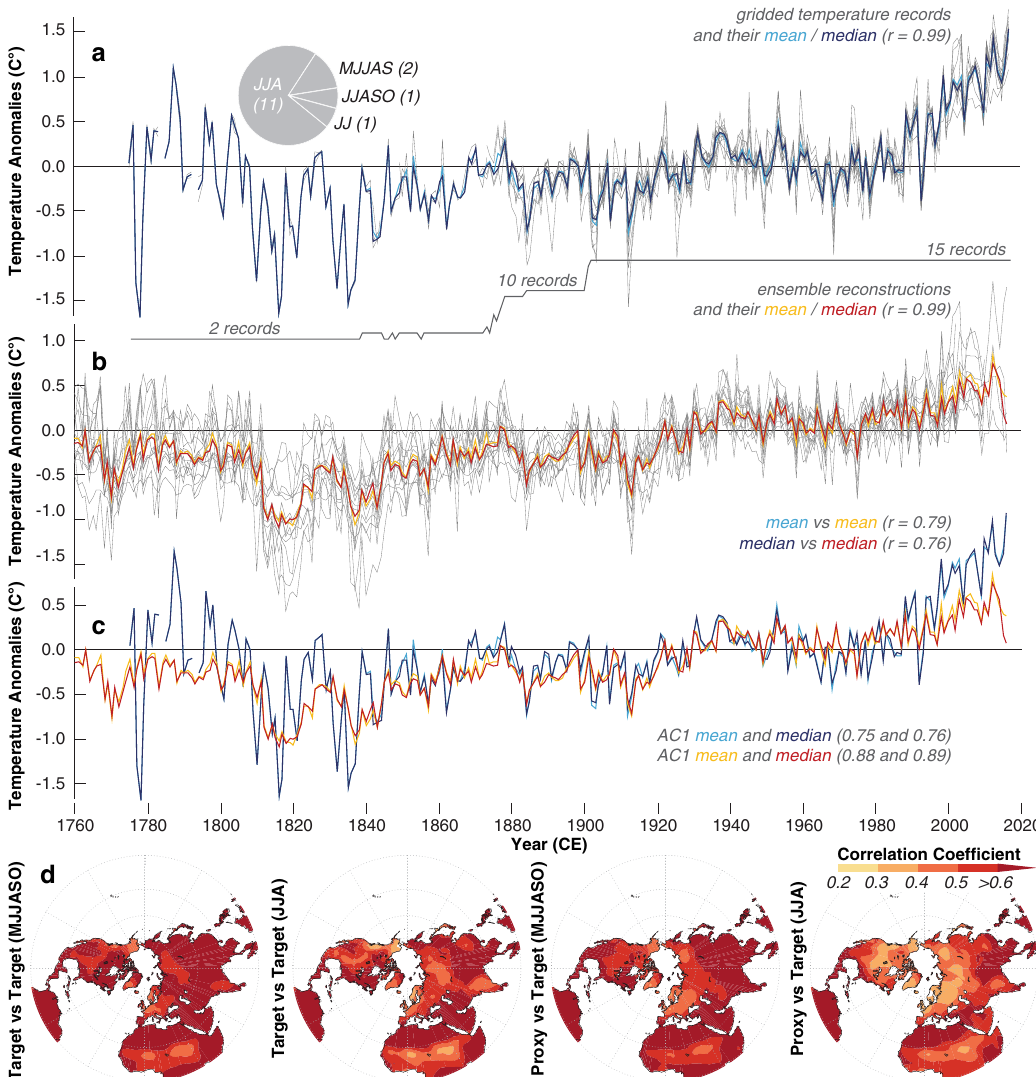
Fig. 3 Measured and reconstructed temperatures. a Gridded temperature measurements (grey lines), together with their mean and median time-series (see the “ Methods ” section for details). The pie chart shows the seasonal averages used, and the lower grey solid line refers to the number of records. b Ensemble reconstructions (grey lines), together with their mean and median (orange and red). The mean and median of both, the proxy and target data are statistically similar ( r = 0.99). c Measured and reconstructed temperature means and medians. d Spatial fi eld correlations between the mean of all 15 temperature targets and gridded Berkeley data (Target versus Target), and the ensemble reconstruction mean and gridded Berkeley data (Proxy versus Target), calculated over 1794 – 2016